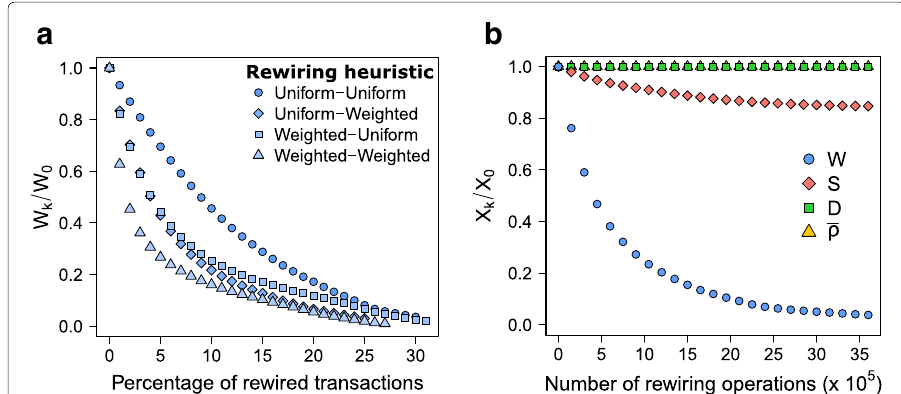
Fig. 2 Decreasing spatial inequality in the city by adapting daily shopping destinations. a Decrease of wealth inequality among neighborhoods as a function of the fraction of transactions rewired, for various rewiring methods. Four combinations of choice heuristics are considered, “Uniform-Uniform”, “Uniform-Weighted”, “Weighted-Uniform” and “Weighted-Weighted”. b Decrease of wealth inequality ( W k / W 0 ) while preserving the spatial mixing index ( S k / S 0 ), the total distance traveled ( D k / D 0 ) and the exploration rate ( ¯ ρ k / ¯ ρ 0 ), as a function of the number of rewiring operations. Values have been averaged over hundreds of replications. The bars represent the minimum and the maximum values obtained but in most cases are too close to the average to be seen (see Additional file 1: Figure S10-S11 for